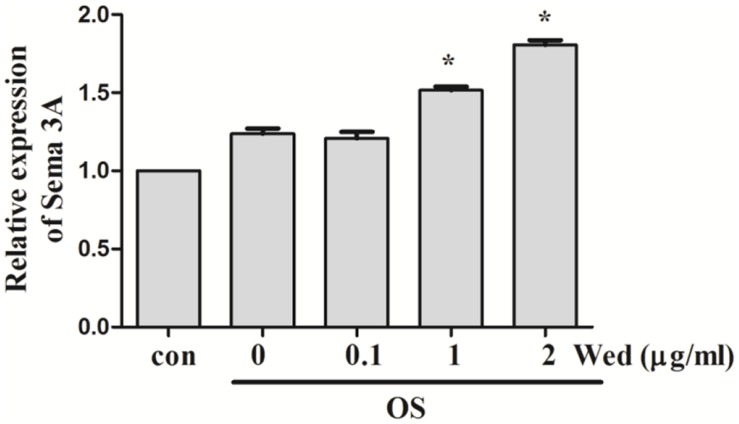
Effect of wedelolactone on Sema3A mRNA expression in BMSC. BMSC were incubated with OS medium containing wedelolactone for 9 days. Total RNA was then isolated. Gene expression was analyzed by rt-qPCR with Sema3A specific primer sets. The expression levels were normalized to the housekeeping genes Actb. Data are expressed as mean ± SEM of three independent experiments. ∗P < 0.05 compared with OS-treated control.